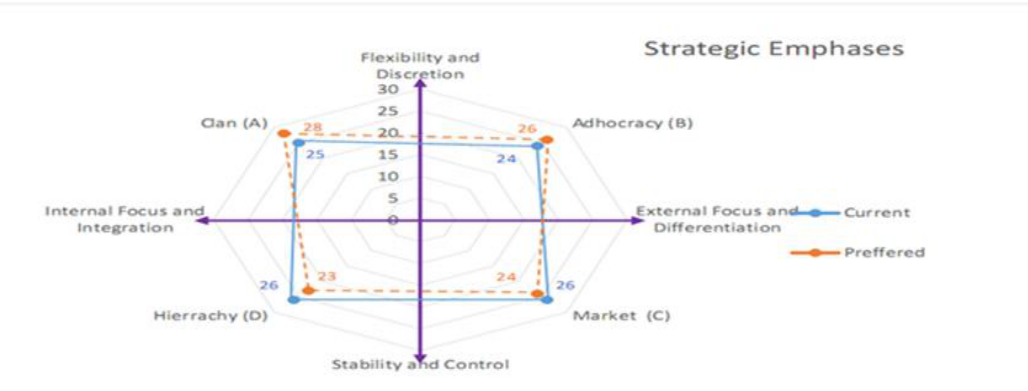
Figure 8. Radar diagram of dimension of strategic